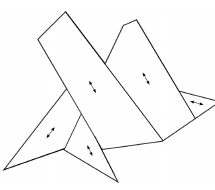
Figure 12. Convex decomposition for the polygon P 2 by our method. Table 2. Performance comparison with P